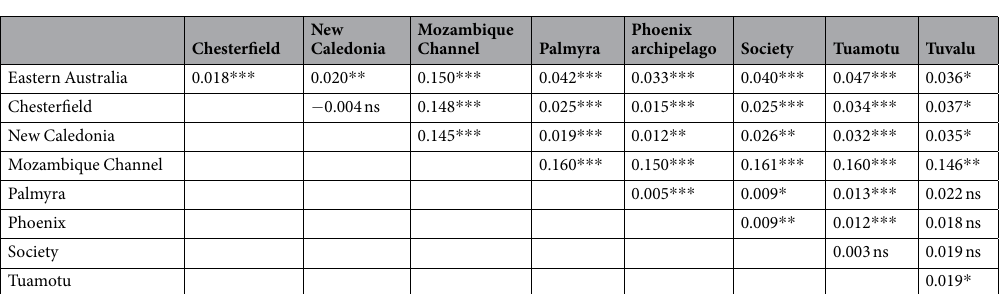
Table 2. Pairwise F st values among the nine samples of the gray reef sharks from the Indo-Pacific. Significance is given as follows: ns = non-significant, * p-value < 0.05, ** p-value < 0.01, *** p-value < 0.001.